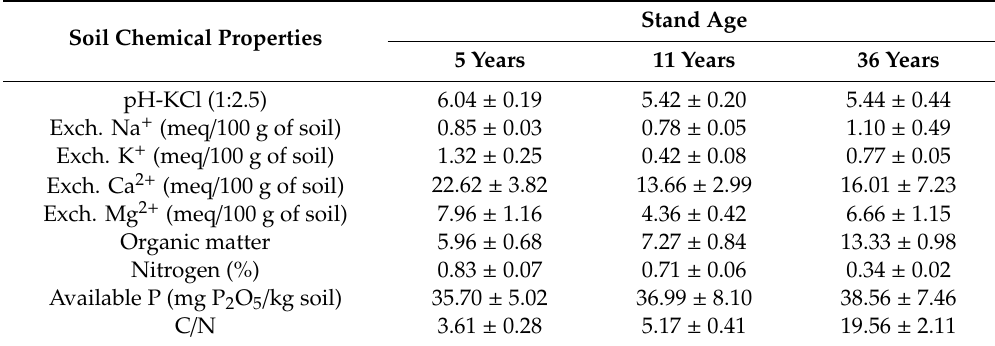
Table 1. Selected chemical properties of soil samples from the study plots in Pinus patula plantations in Wondo Genet area,